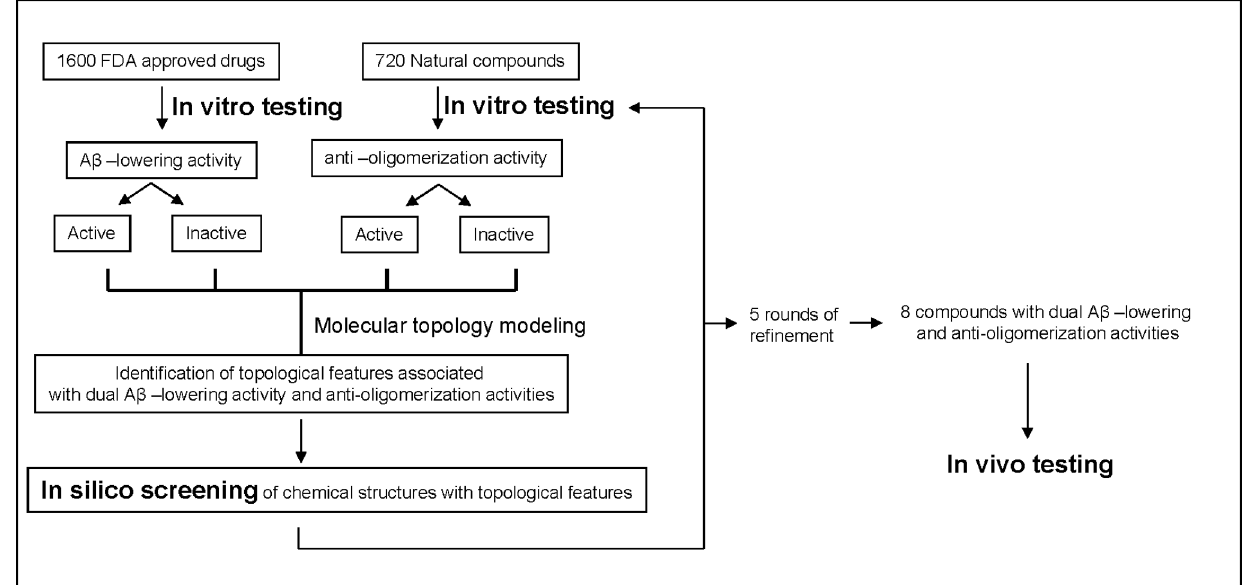
Figure 2. Schematic drug discovery procedure using molecular topology modeling.